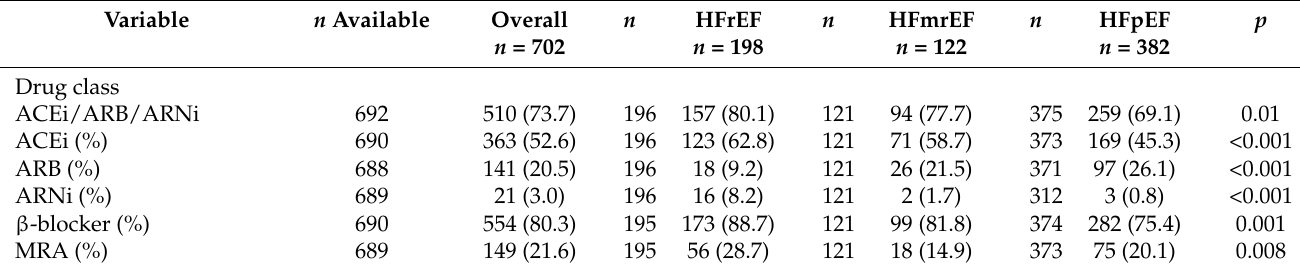
Table 4. Specifics of HF drug prescriptions according to HF phenotype §